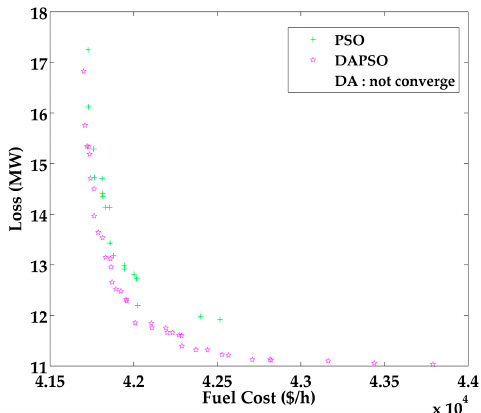
Figure 7. Two-dimensional Pareto fronts when considering fuel cost and transmission losses as part of the objective function for the IEEE 57-bus system.